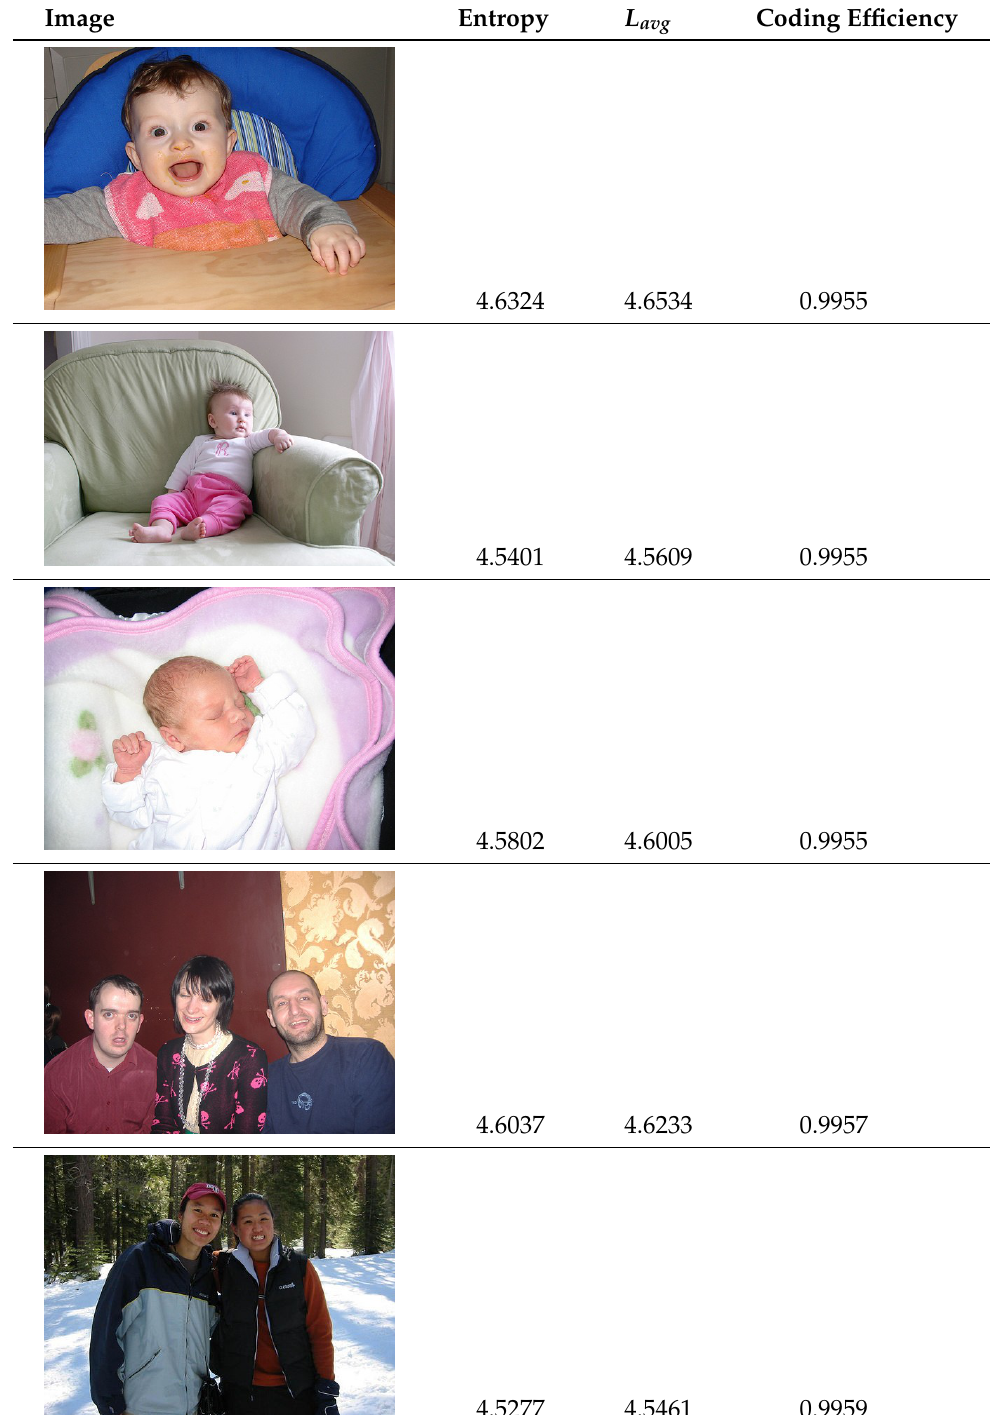
Table 3. The Huffman coding